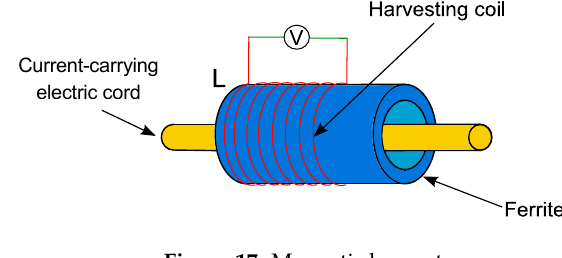
Figure 17. Magnetic harvester.